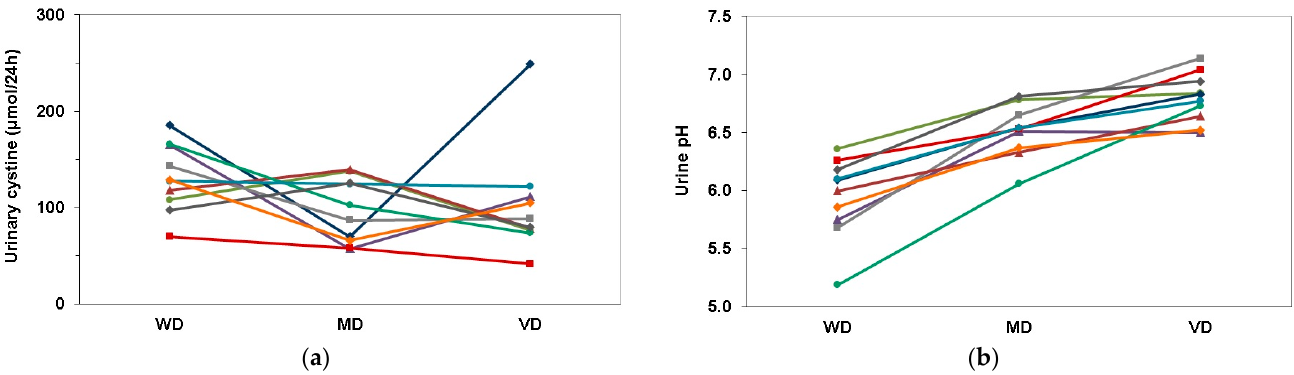
Figure 1. Individual course of 24 h urinary parameters of all participants on the different diets: ( a ) Urinary cystine excre-